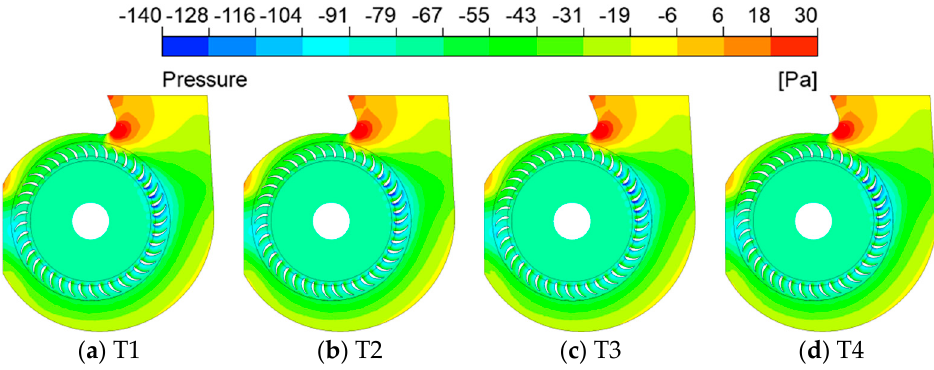
Figure 11. Distribution of static pressure on Z = 4 mm cross-section for the r = 13 mm model.